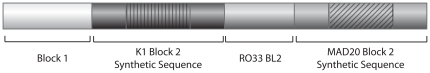
Schematic representation of the MSP-1 hybrid vaccine construct, based on the polymorphic N-terminal region of MSP-1.The construct encodes the N-terminal MSP-1 Block 1 region, the K1 Block 2 synthetic sequence, the RO33 Block 2 sequence and the MAD20 Block 2 synthetic sequence of MSP-1 of P. falciparum. Synthetic Block 2 repeat sequences of the K1 and MAD20 serotypes are indicated by vertical and diagonal hatched markings respectively.